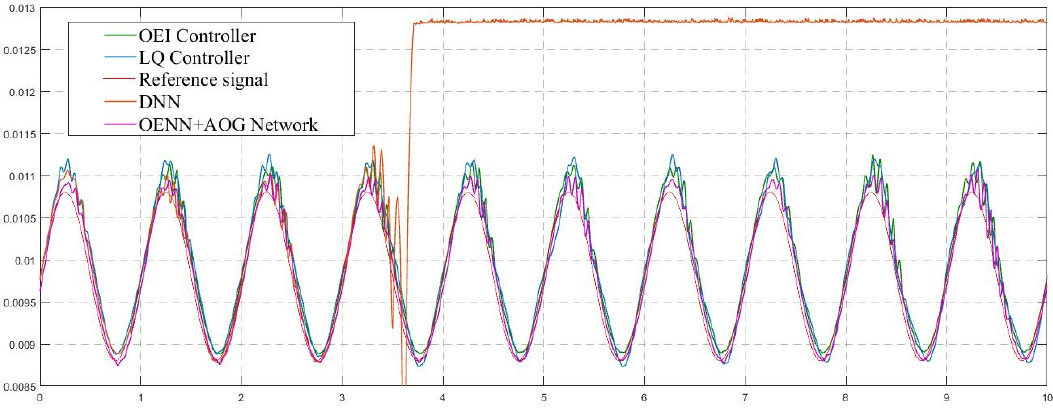
Figure 6. Tracking performances (position measurements).